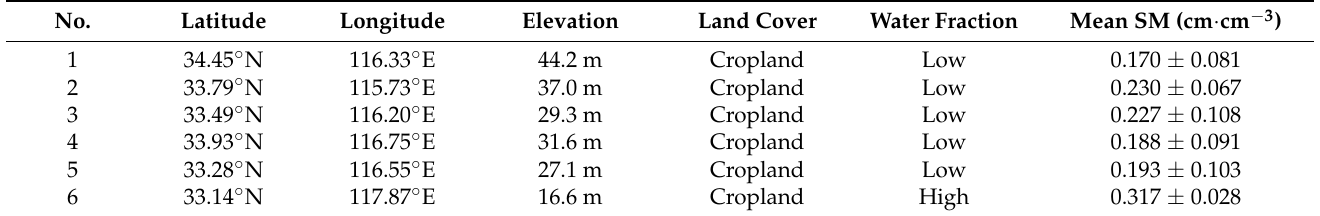
Figure 1. Location of soil moisture observations in Anhui Province, with ( a ) topographical data from the Global Digital Elevation Model and ( b ) 2019 LULC data from Yang and Huang [37]. Table 1. List of soil moisture observational stations used in this study. High water fraction means the site is close to large rivers, lakes or reservoirs in the surrounding area of a typical SM grid (25 × 25 km).